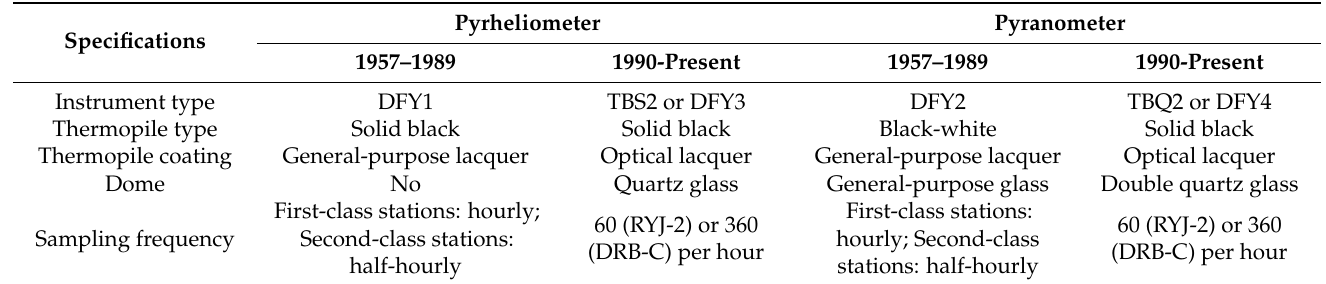
Table 2. Instruments and measurement methods used for solar energy resource potential ( R s )